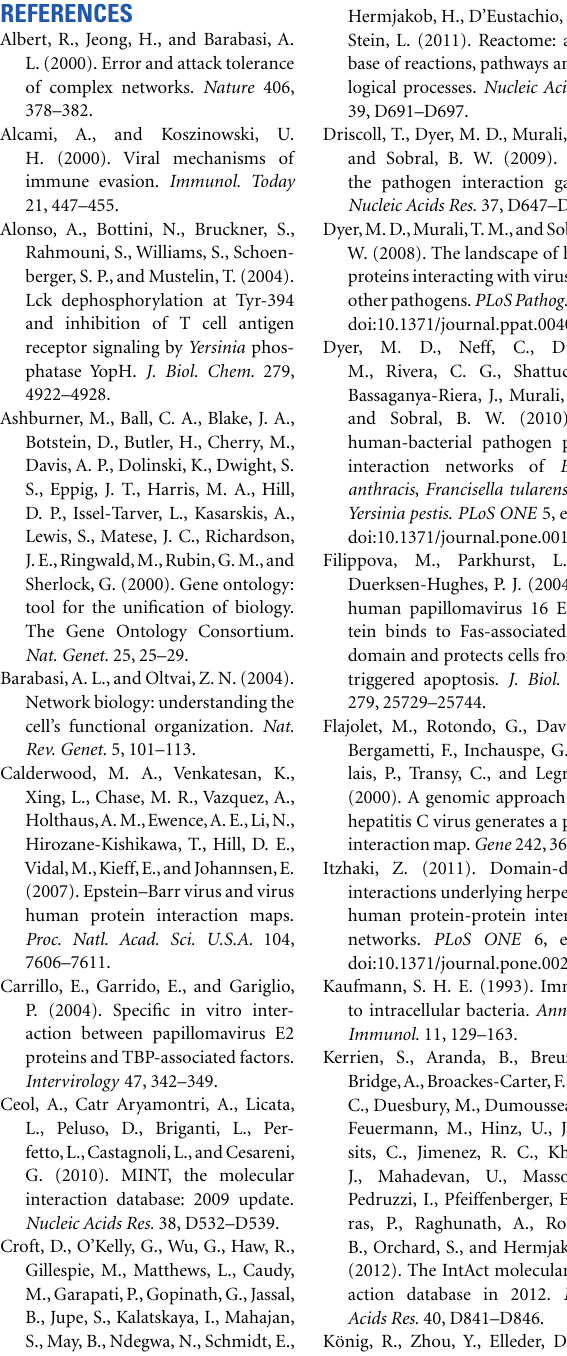
Data Sheet 6 | Gene ontology enrichment results of sets of human proteins targeted by each bacterial group. Data Sheet 7 | Gene ontology enrichment results of sets of human proteins targeted by each fungal group. Data Sheet 8 | Gene ontology enrichment results of sets of human proteins targeted by each protozoan group.